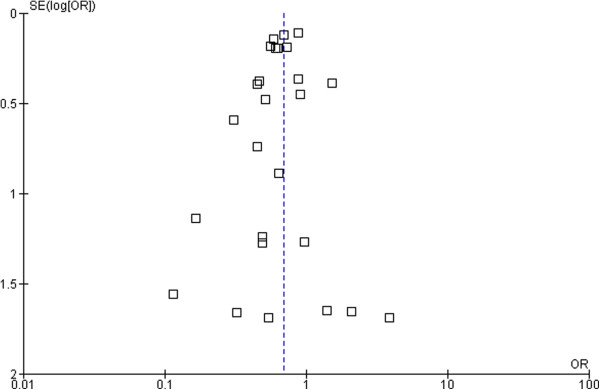
Funnel plot of SE (log odds ratio) by odds ratio to evaluate publication bias for effect of treatment in sudden cardiac death (SCD).